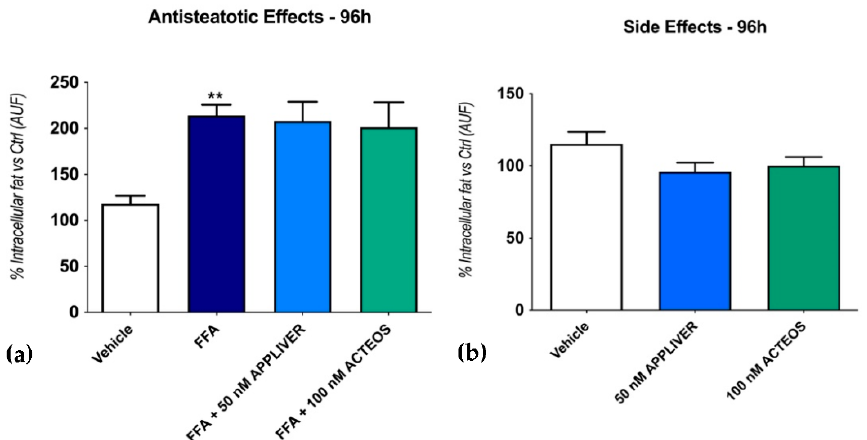
Figure 2. Assessment of the effect of APPLIVER and ACTEOS as antisteatotic ( a ) and its side effects ( b ) after 96 h on SCC. Values presented are the mean ± SD of three independent experiments. ** p < 0.01 vs. vehicle. Abbreviations: AUF, arbitrary unit of fluorescence; FFA, free fatty acids.